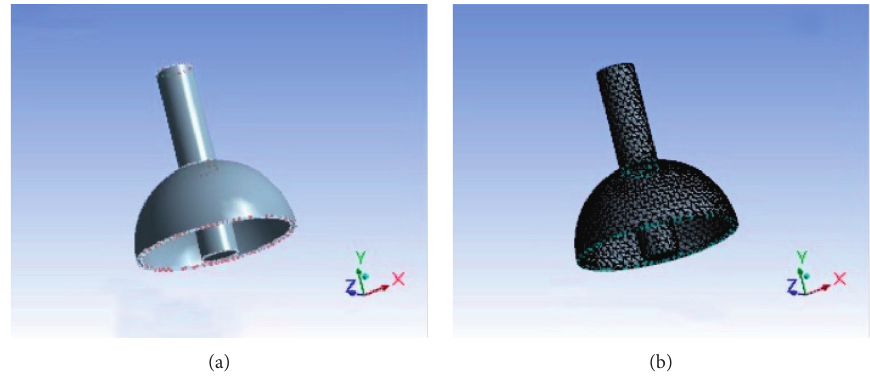
Figure 7: The grid and model of the hemispherical resonator.